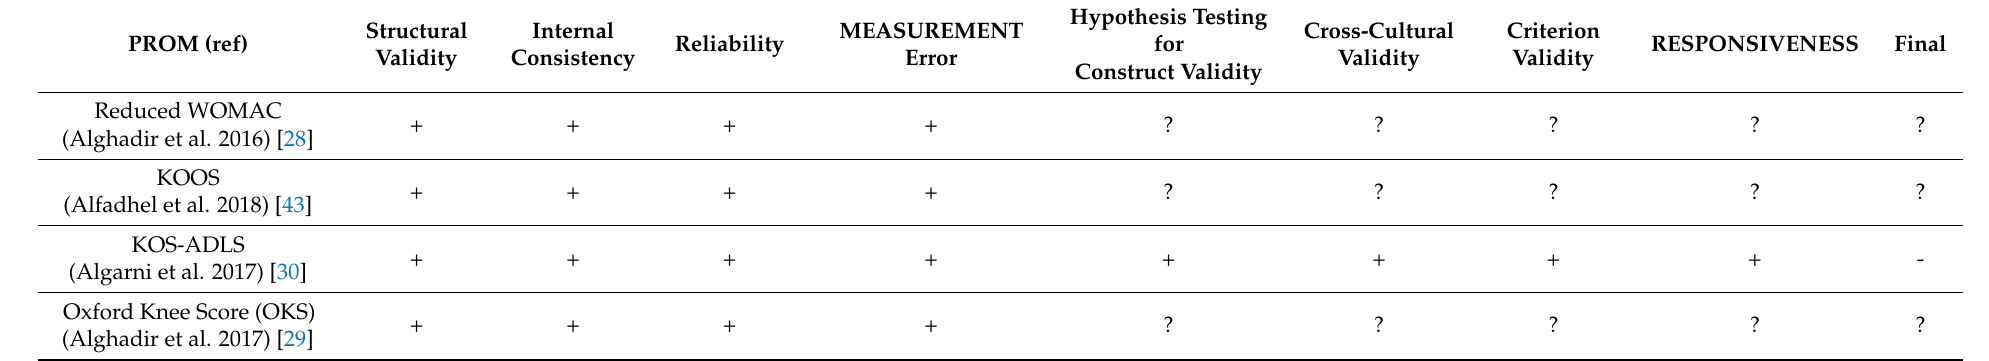
Table 5. The methodological quality of PROMs related to knee joint according to the COSMIN